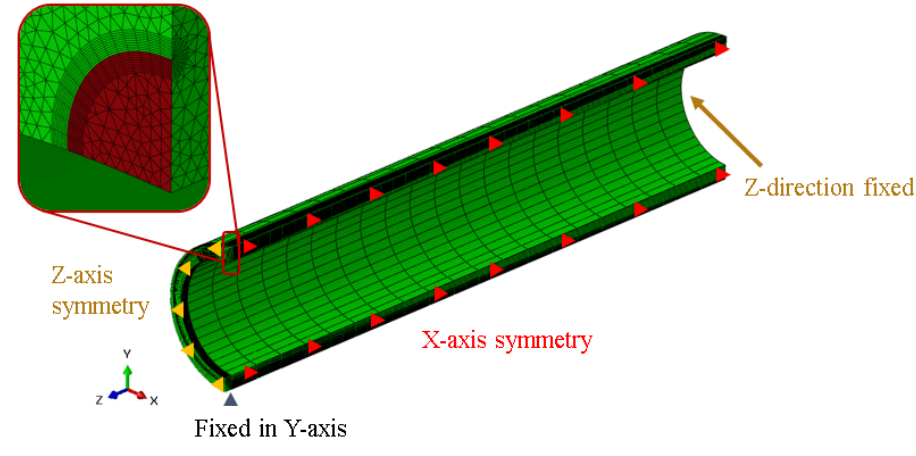
Figure 12. FE model and boundary conditions of a pipe with semi-elliptical surface crack .